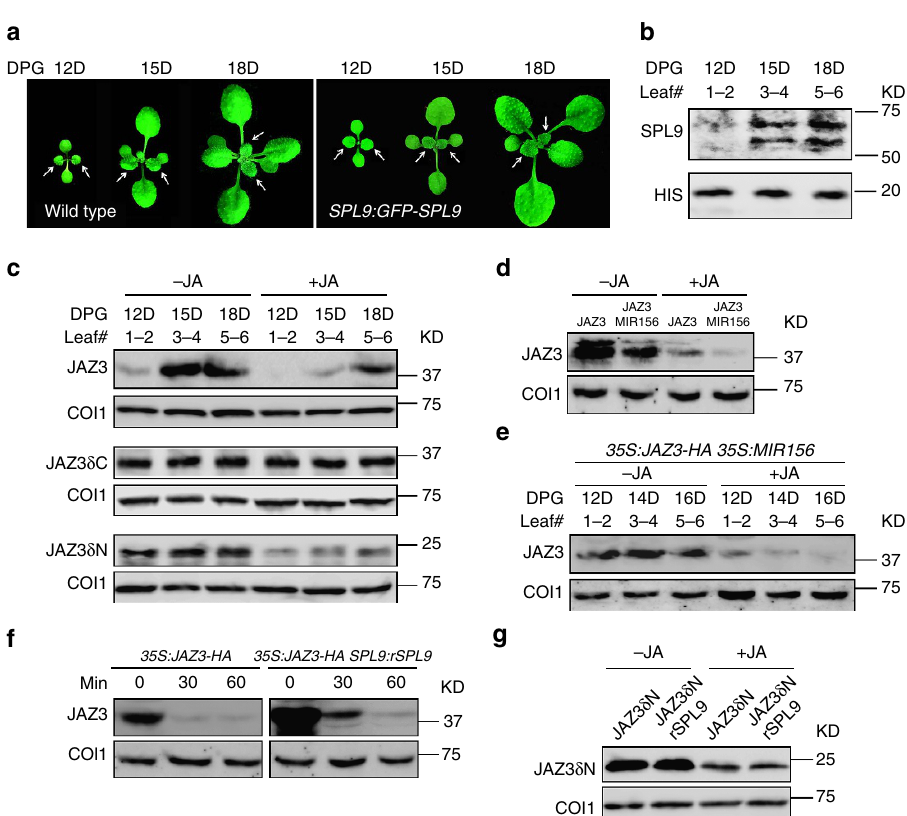
Figure 5 | SPL9 promotes JAZ3 protein accumulation. ( a ) Images of wild-type and SPL9:GFP-SPL9 plants in LD at indicated days post germination (DPG). White arrows indicate new leaves (leaf #1–2, 3–4 and 5–6). ( b – g ) Protein levels of SPL9 and JAZ3 in new leaves. KD, kilodalton. ( b ) SPL9-GFP fusion protein in new leaves as described in a were detected by anti-GFP antibody, the protein level increased with plant age. ( c – g ) JAZ3-HA accumulation with plant age. Plants in LD were treated with 50 m M MeJA ( þ JA) or ethanol (-JA), and new leaves were collected one hour later or at the indicated time post treatment for immunoblotting. JAZ3-HA or the truncated versions were detected using anti-HA antibody. COI1 in each sample was detected using anti-COI1 antibody. ( c ) JAZ3-HA (top), JAZ3 d C-HA (middle) and JAZ3 d N-HA (bottom) proteins in leaves (leaf #1–2, 3–4 and 5–6) harvested from 35S:JAZ3-HA , 35:JAZ3 d C-HA and 35S:JAZ3 d N-HA plants at the indicated DPG. The JAZ3-HA fusion protein, but not its truncated versions, exhibited the age-dependent accumulation. ( d ) JAZ3-HA level was decreased in the 35S:MIR156 background. The first pair of leaves from 35S:JAZ3-HA (JAZ3) and 35S:JAZ3-HA 35S:MIR156 (JAZ3 MIR156) plants were collected for analysis. ( e ) JAZ3-HA level was similar among leaves (leaf #1–2, 3–4 and 5–6) harvested from 35S:JAZ3-HA 35S:MIR156 plants at the indicated DPG. ( f ) JAZ3-HA level was increased in the SPL9:rSPL9 background. The first pair of leaves from 35S:JAZ3-HA and 35S:JAZ3-HA SPL9:rSPL9 plants were analysed. ( g ) JAZ3 d N-HA protein level in 35S:JAZ3 d N-HA and 35S:JAZ3 d N-HA SPL9:rSPL9 plants, which was uncoupled from